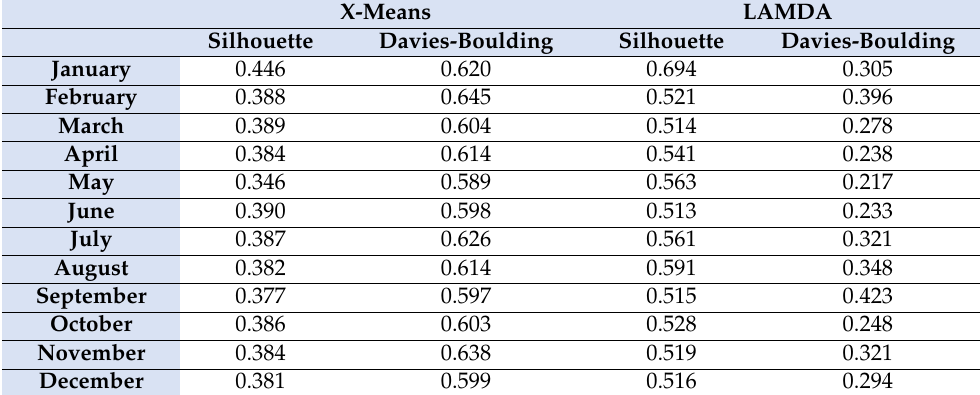
Table 1. Results of the clustering algorithms.